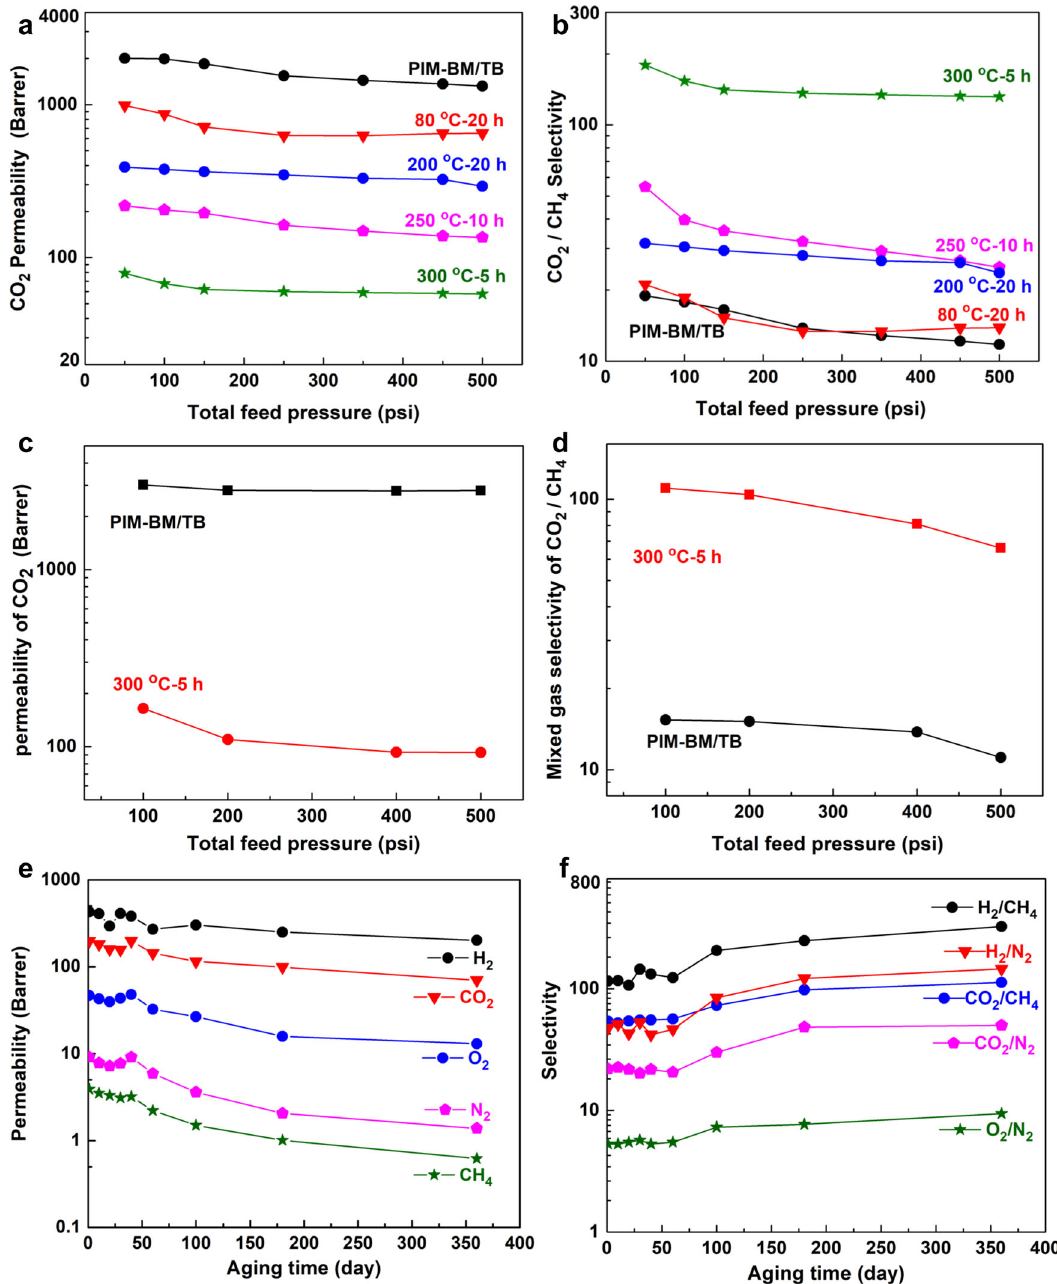
Fig. 8 Effects of feed pressures and physical ageing on membranes. a Pure CO 2 permeability versus feed pressure. b CO 2 /CH 4 ideal selectivity versus feed pressure. c CO 2 permeability versus feed pressure for separating equimolar CO 2 /CH 4 gas mixtures. d CO 2 /CH 4 selectivity versus feed pressure for separating equimolar CO 2 /CH 4 gas mixtures. e Pure gas permeability versus aging time of XPIM-BM/TB- 250 °C-10 h. f Gas selectivity versus aging time of XPIM-BM/TB- 250 °C-10